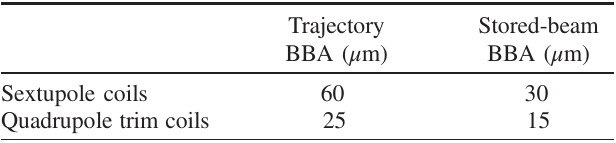
TABLE VII. Achievable accuracy of simulated BBA on sextu- pole magnets using either the sextupole or the quadrupole trim